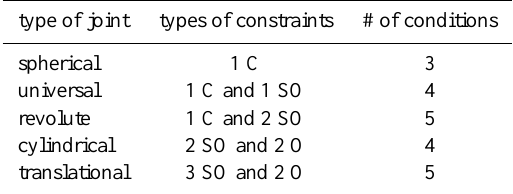
Table 1. Di ff erent types of